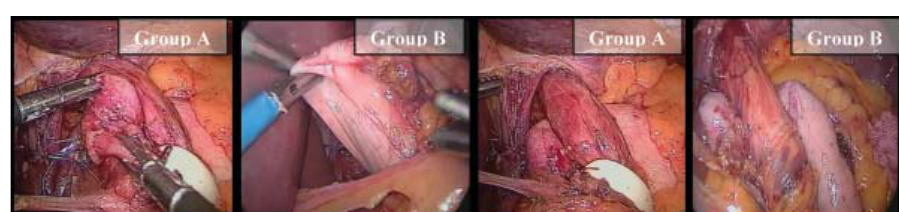
FIGURE 3 - Gastric fundus posterior wall mobilized (A and B) and the positioning of the gastric fundus without instrument fi xation (C and D)